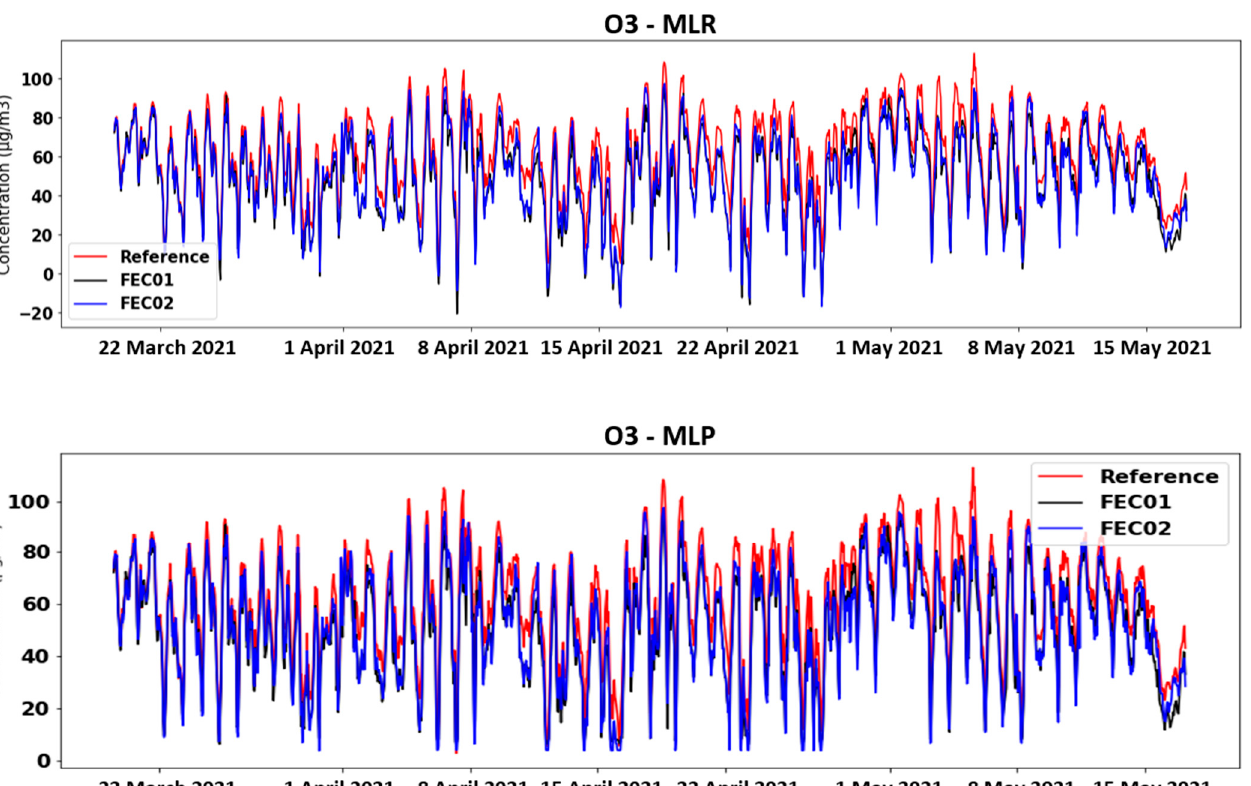
Figure 6. Time chart of O 3 concentrations obtained with MLR and MLP calibration techniques.